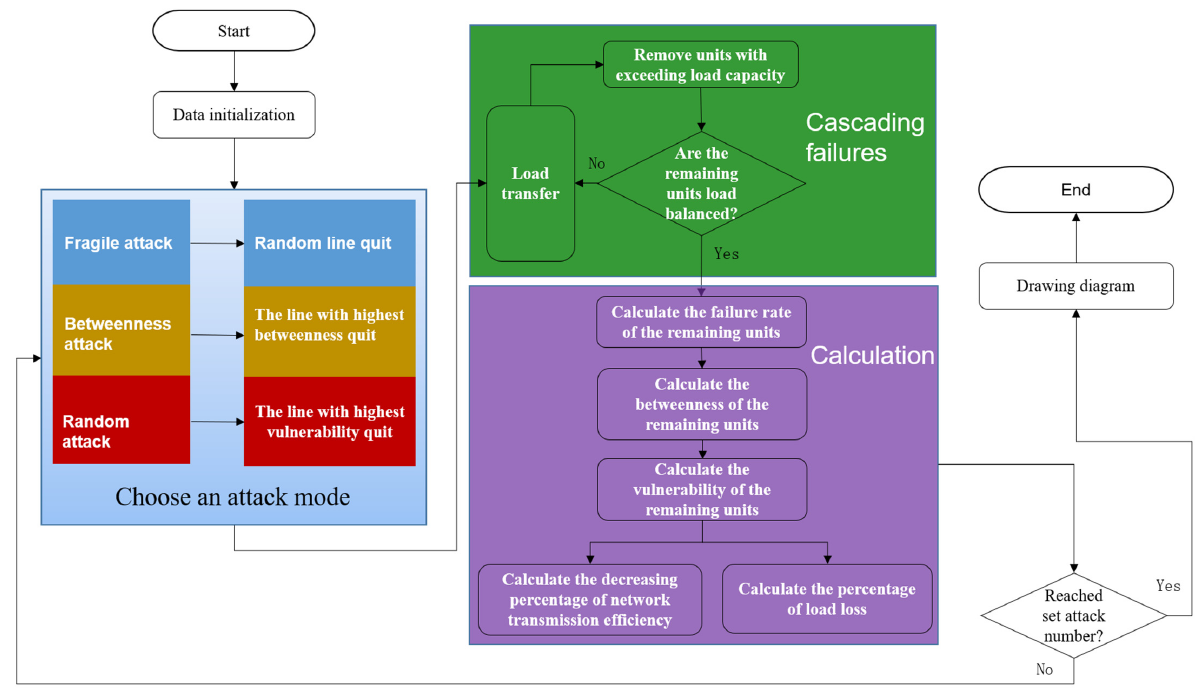
Figure 10. Flow chart of vulnerability analysis of power grid structure.